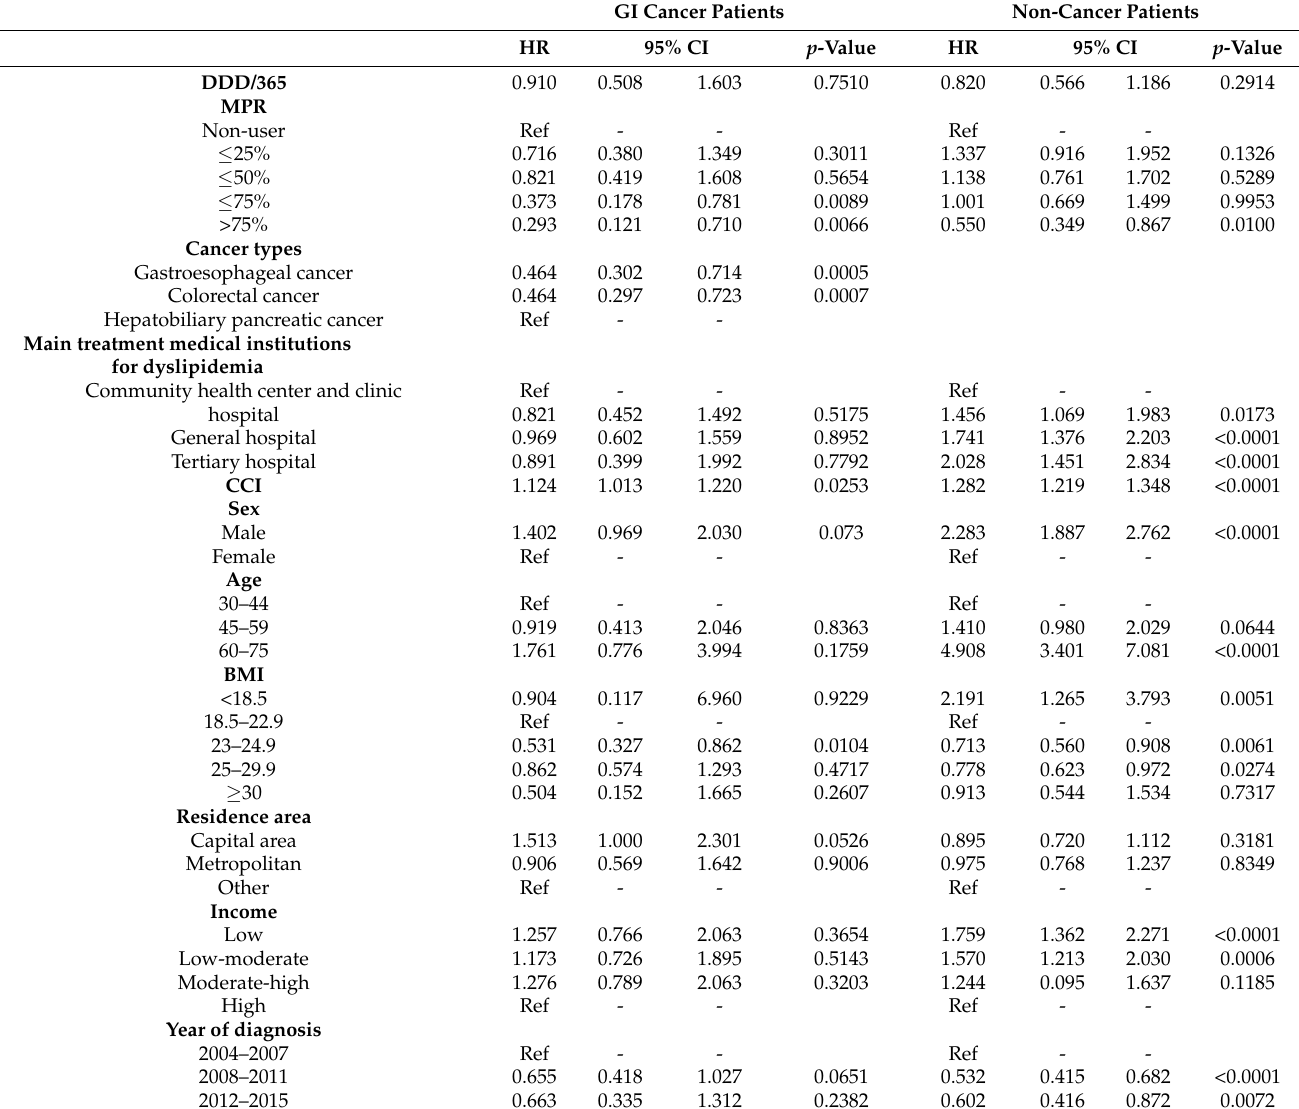
Table 2. The multivariate Cox regression analysis of the association of continued statin use and mortality after diagnosis in dyslipidemia